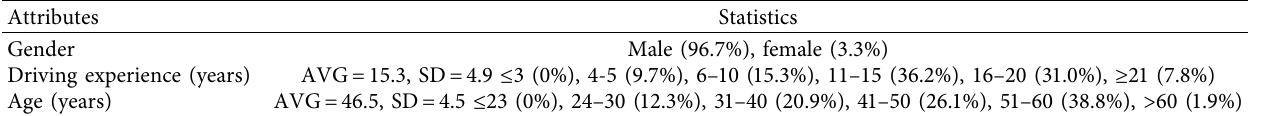
Table 2: Descriptive statistics of respondents.